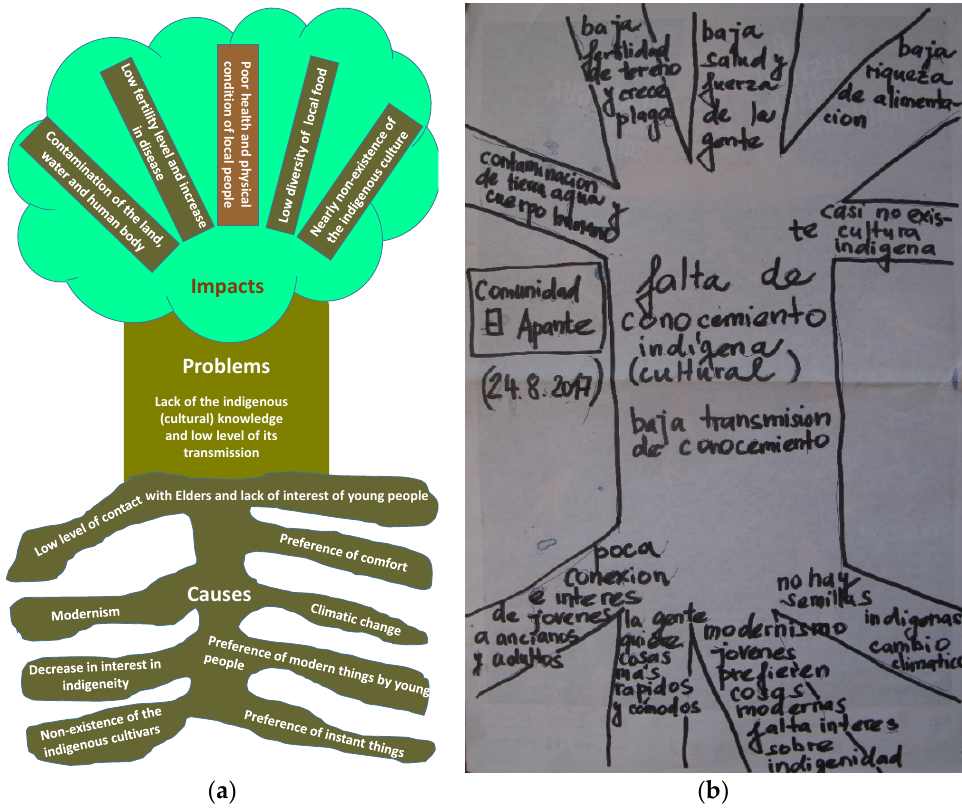
Figure 4. “Tree of problems” designed as a conclusion of the focal group discussion. ( a ) Schematic transcription in English; and, ( b ) Original picture.